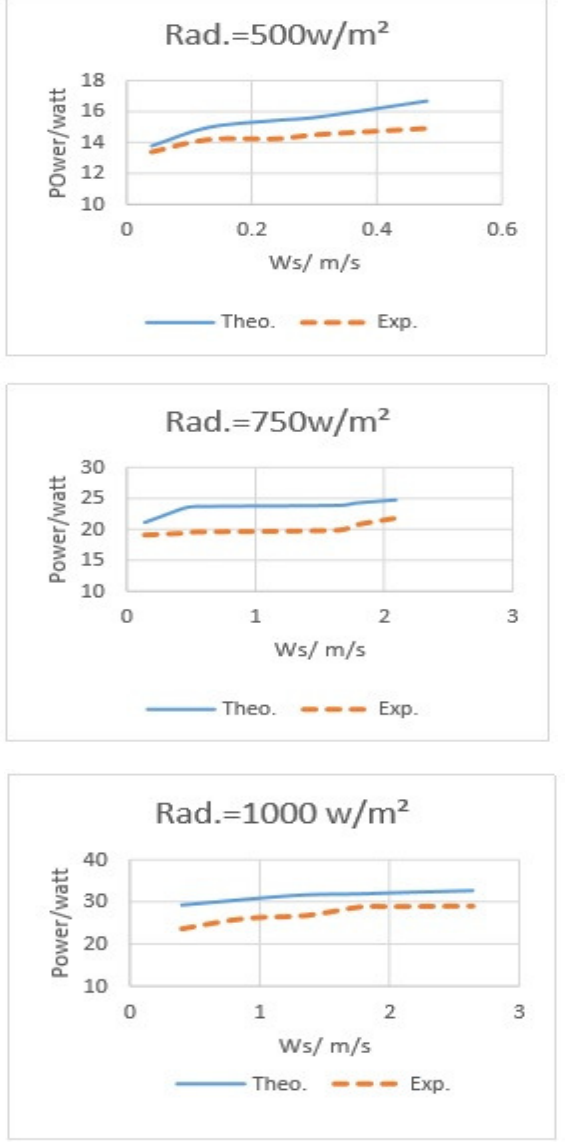
Fig. 8. Effect of wind speed on power of monocrystalline PV solar cell at different radiation intensities.